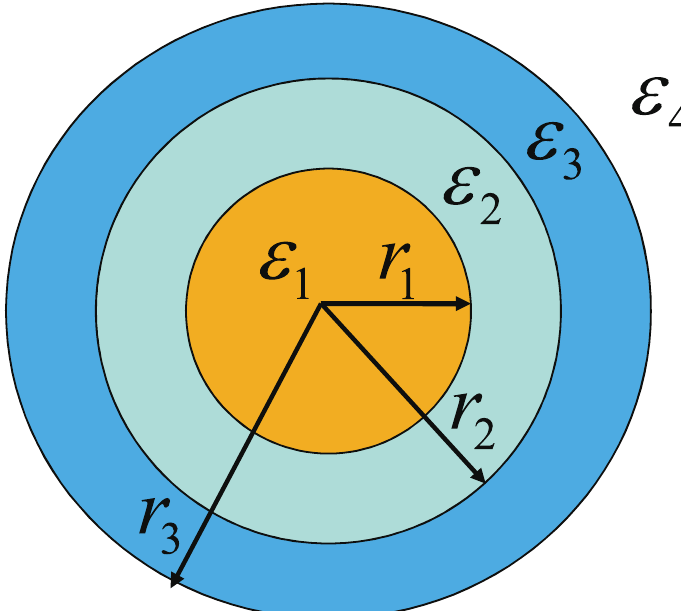
Figure 1. The geometry of bimetallic three-layered nanoshell. r 1 , r 2 , and r 3 are the radii of inner core, middle dielectric layer, and outer nanoshell. ε 1 , ε 2 , ε 3 , and ε 4 are the dielectric functions for the inner core, dielectric layer, outer nanoshell, and surrounding medium,